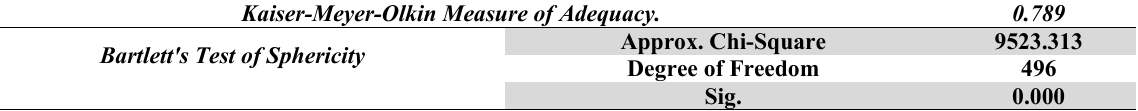
KMO and Bartlett's Tests Kaiser-Meyer-Olkin Measure of